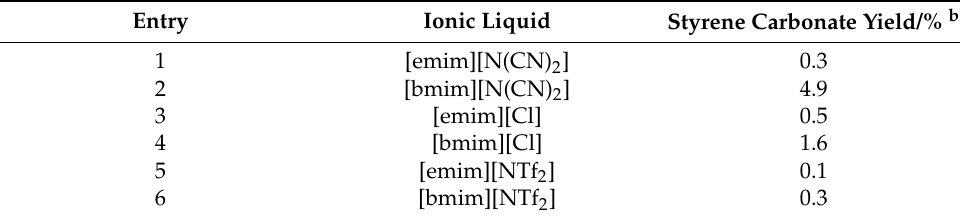
Table 2. Cycloaddition a of CO 2 to styrene epoxide in different ionic liquids.